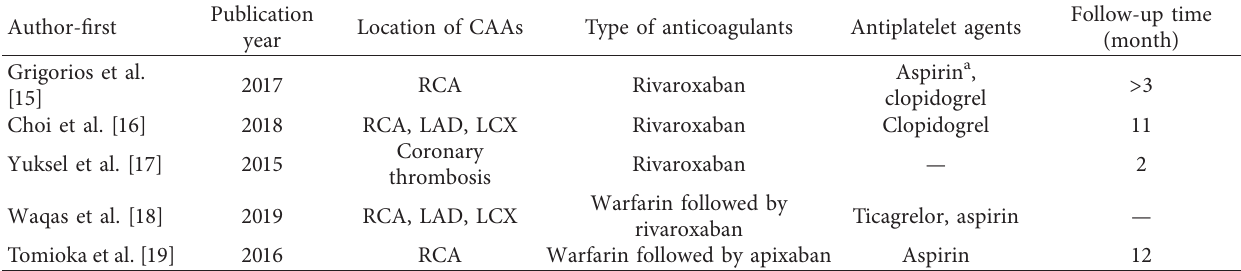
Table 1: The cases of treating CAAs with